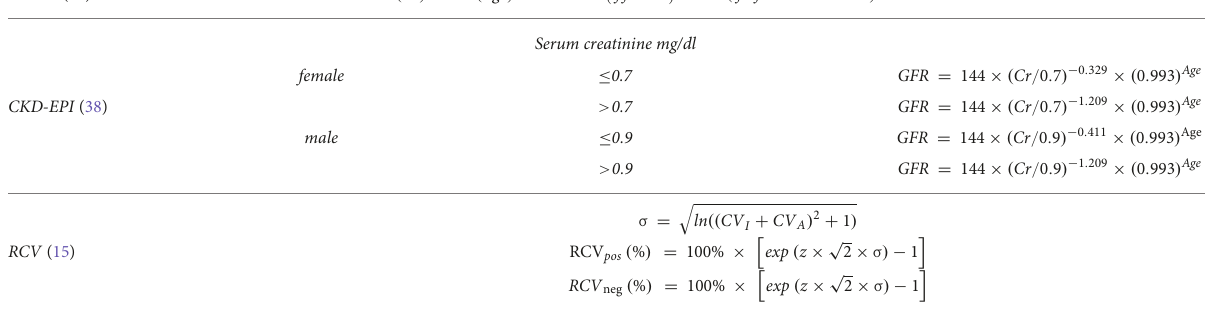
TABLE 1 Different equations for estimated glomerular filtration rate (eGFR) and RCV equation. MDRD